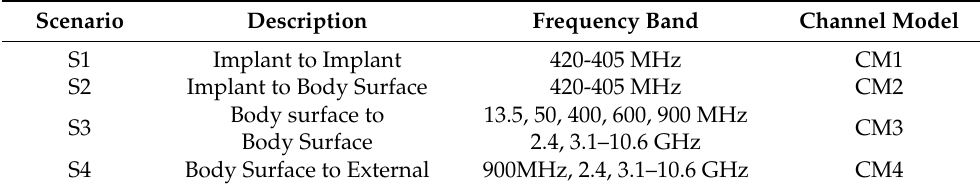
Figure 3. Possible communication links for body area networking. Table 9. Descriptions of IEEE 802.15.6 channel models. Data from Ref.